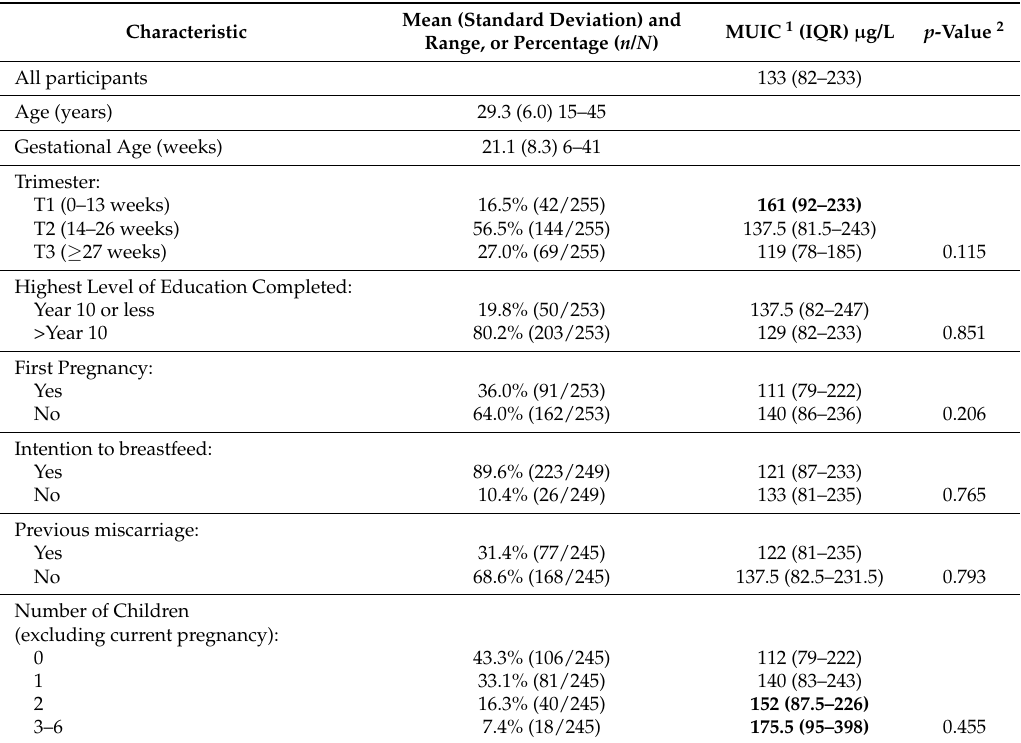
Table 1. Characteristics of pregnant women ( n = 255) at enrolment and associated group median urinary iodine concentration